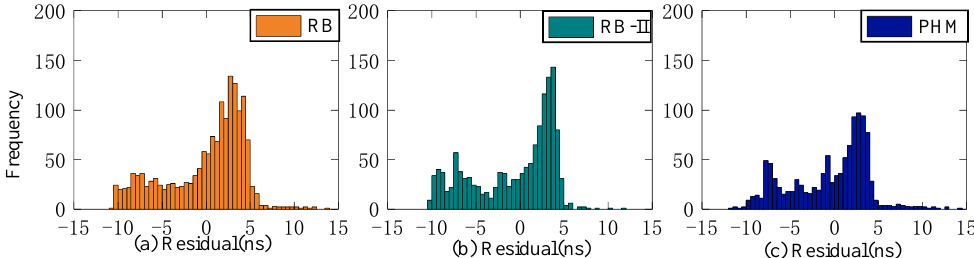
Figure 26. Multiday prediction residual statistics of the SSA-ELM model. ( a ) The residual distribution of the RB clock. ( b ) The residual distribution of the Rb-II clock. ( c ) The residual distribution of the PHM clock.